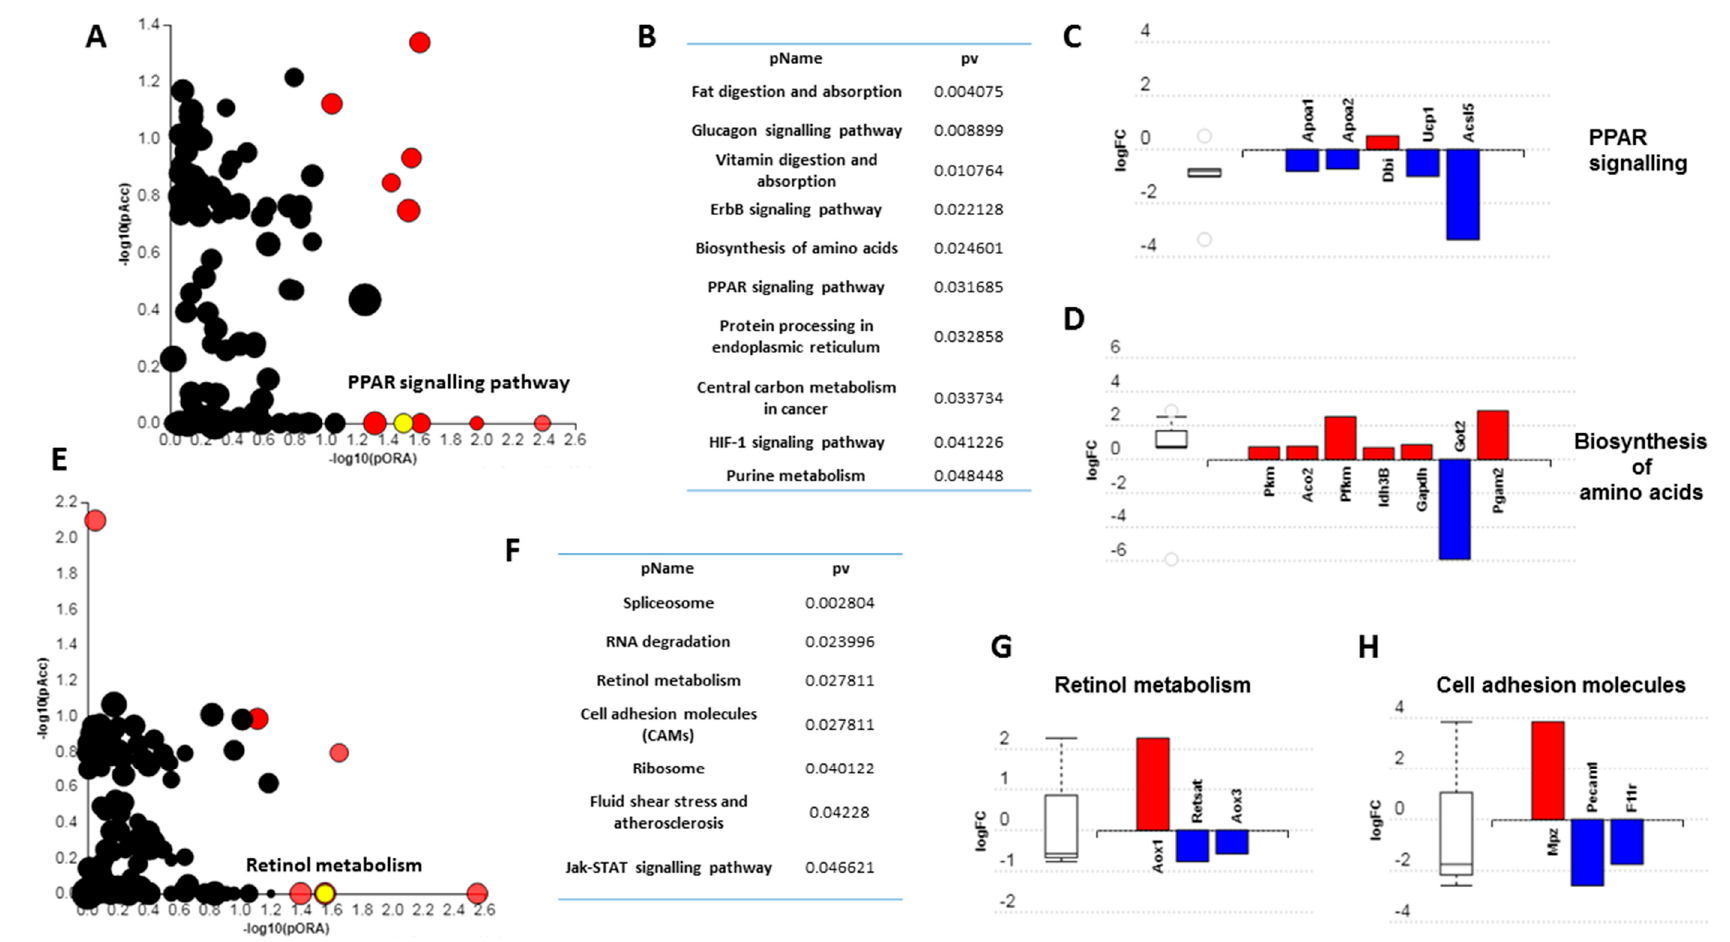
Figure 3. Overview of alterations in the proteome of iBAT and PVAT following 72h of high fat feeding. Impact analysis: iBAT ( A ), PVAT ( E ); Most impacted pathways: iBAT ( B ), PVAT ( F ); Proteins altered in specified pathways: iBAT ( C , D ), PVAT ( G , H ). Figures created with Advaita Bio IPathwayGuide using only di ff erentially altered proteins. Peroxisome proliferator-activated receptor (PPAR).